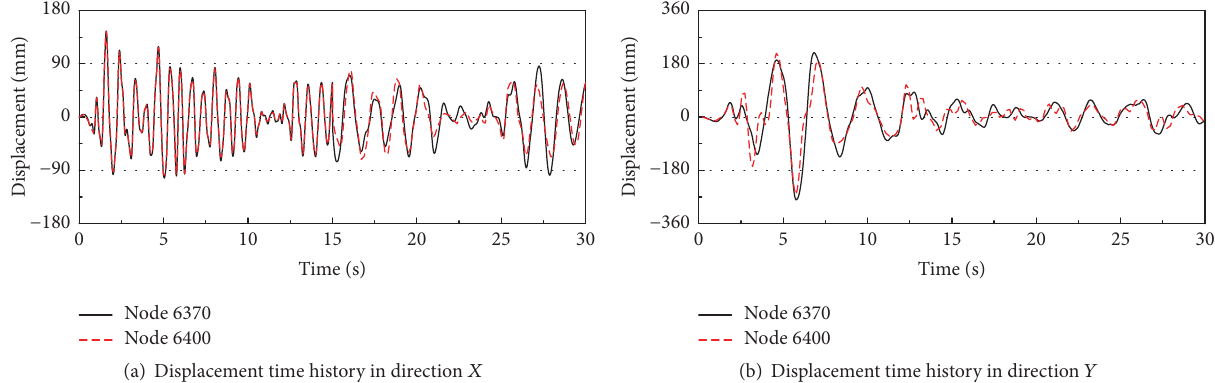
Figure 15: Displacement of node 6370/6400 under El-Centro of rare intensity.